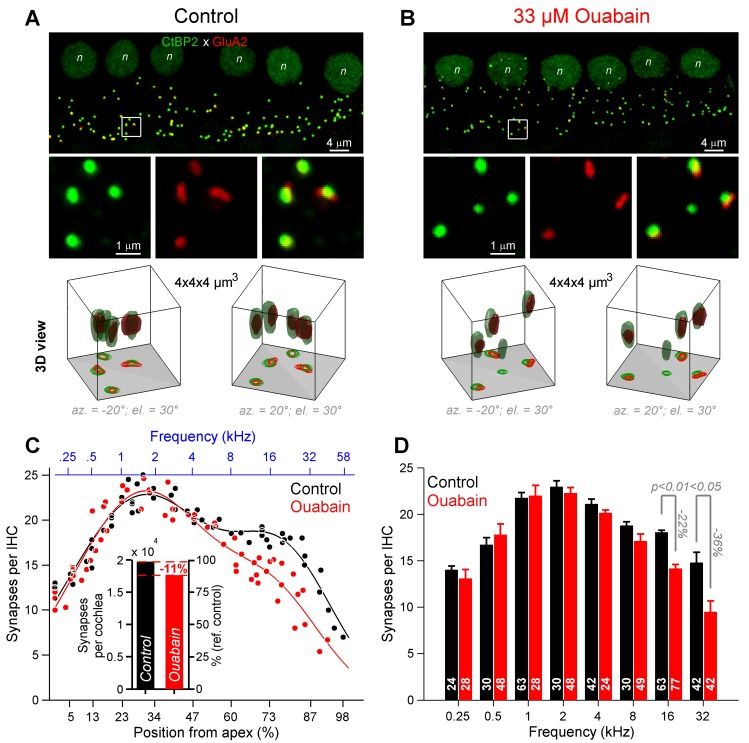
Synapse counts in control and ouabain-poisoned cochleae.(A, B) Confocal microscopy of immunolabeled CtBP2 (green) and GluA2 (red) from the 16-kHz encoding region in artificial perilymph control (A) and ouabain-poisoned cochleae (B). Top panel: enlarged view of inner-hair-cell innervation (6 IHCs; n indicates the nucleus of IHCs). Middle panel: z-projection of the white square shown above (4 μm × 4 μm), showing CtBP2 and GluA2 immunolabeling alone or together (merged). Bottom panel: Three-dimensional (3D) views of the white square shown above (4 μm × 4 μm × 4 μm). Note the presence of an orphan ribbons in ouabain-poisoned condition (B, 12 ± 2% in the basal end (>5.6 kHz) against 1 ± 0.6% in the apical end (<5.6 kHz). (C) Number of synapses per IHC along the gerbil tonotopic axis [24] in control and ouabain-poisoned cochleae (black, control, 5 cochleae, 324 IHCs, 5790 synapses; red, ouabain, 5 cochleae; 344 IHCs, 5494 synapses). Each dot represents the average over 6 consecutive IHCs [14]. Black and red curves are fits using the sum of two Gaussian models (control, black, f(x) = 22.6×exp(-((x-30)/35.2)2) + 14.2×exp(-((x-78.6)/24.1)2), r2 = 0.92; ouabain, red, f(x) = 22.9×exp(-((x-30)/33.4)2) + 9.7×exp(-((x-75.2)/23.6)2), r2 = 0.88, with x the position from the apex in percent). Inset: Estimates of the number of synapses per cochlea calculated from IHC and synapse counts. (black, control: 19,659 synapses/cochlea; red, ouabain: 17,568 synapses/cochlea). (D) Number of synapses per IHC pooled per octave band, in control (black) and ouabain-poisoned (red) cochleae. Numerical values indicate the number of IHCs for which the number of synapses was assessed. Data were expressed as the mean ± SEM, P<0.05, P<0.01, two-way ANOVA test followed by post hoc Tukey’s test.